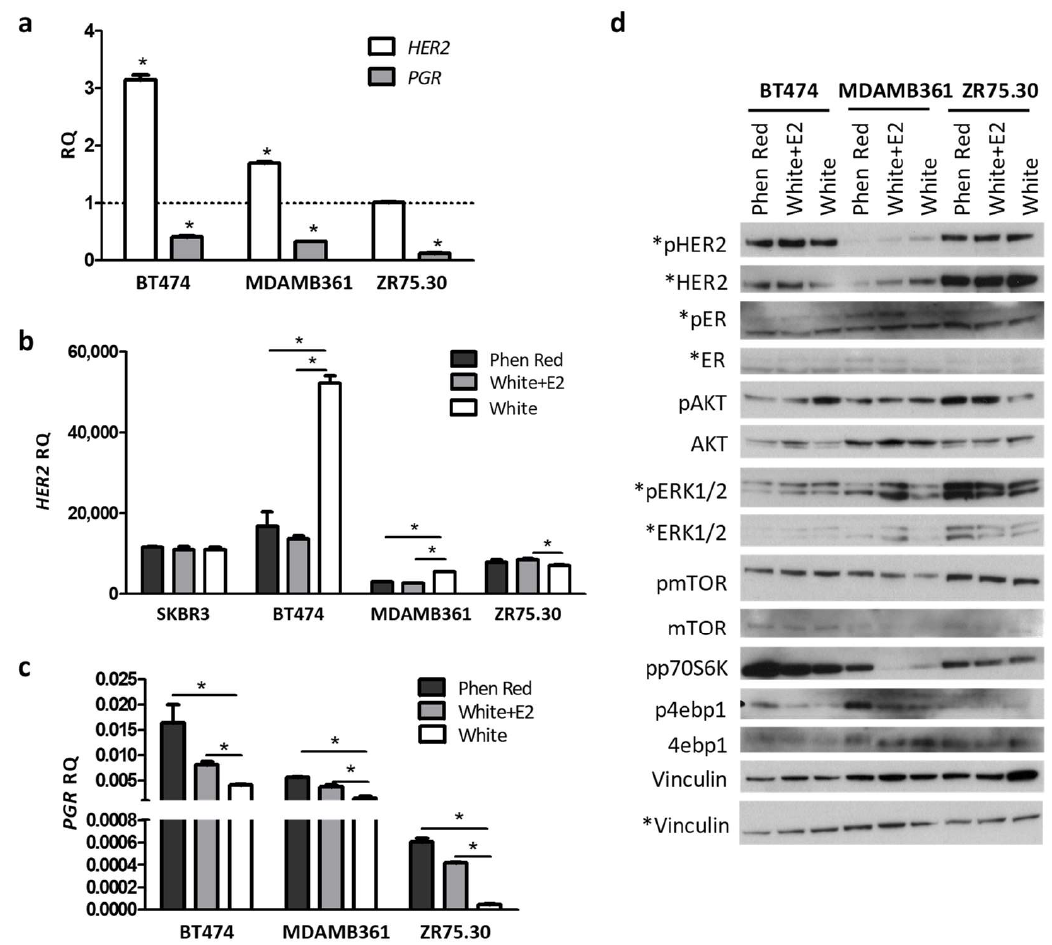
Figure 5. Modulation of ligand-dependent ER activity in ER-positive, HER2-positive BC cell lines. ( a ) HER2 and PGR mRNA levels, as evaluated by qRT-PCR in cells grown in complete medium and treated with 10 nM fulvestrant for 24 h. Data are relative to cells treated with diluent (dotted line), are the mean ± SD of technical replicates and are representative of 3 independent experiments. ( b ) HER2 mRNA levels as evaluated by qRT-PCR in cells grown in complete medium containing 10% FBS (with phenol red) or in white medium with 10% charcoal-stripped FBS, treated with 10 nM estradiol (white + E2) or not (white) for 24 h. Data are the mean ± SD of technical replicates and are representative of 3 independent experiments. ( c ) PGR mRNA expression in cells treated as in ( b ). Data are the mean ± SD of technical replicates and are representative of 3 independent experiments. ( d ) Western blot analysis of cells treated as in b. Representative of two independent experiments. Vinculin was used as a loading control. The asterisks indicate molecules analyzed in a separate gel. * p < 0.05 by unpaired Student’s t test. RQ: relative quantification.